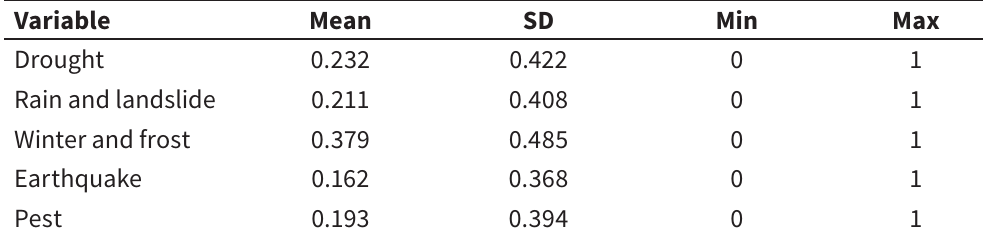
Winter and frost